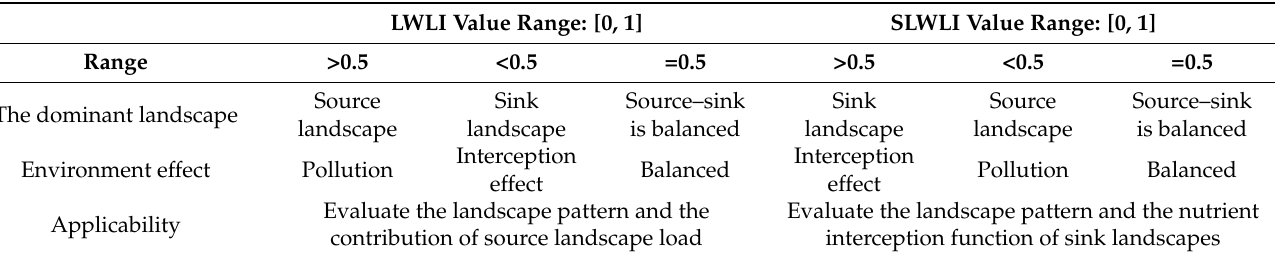
Table 6. Differences between LWLI and